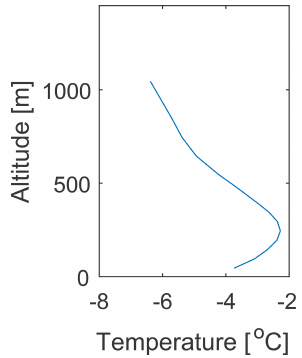
Figure 2. The mean vertical temperature profile used for nudging in the PALM model